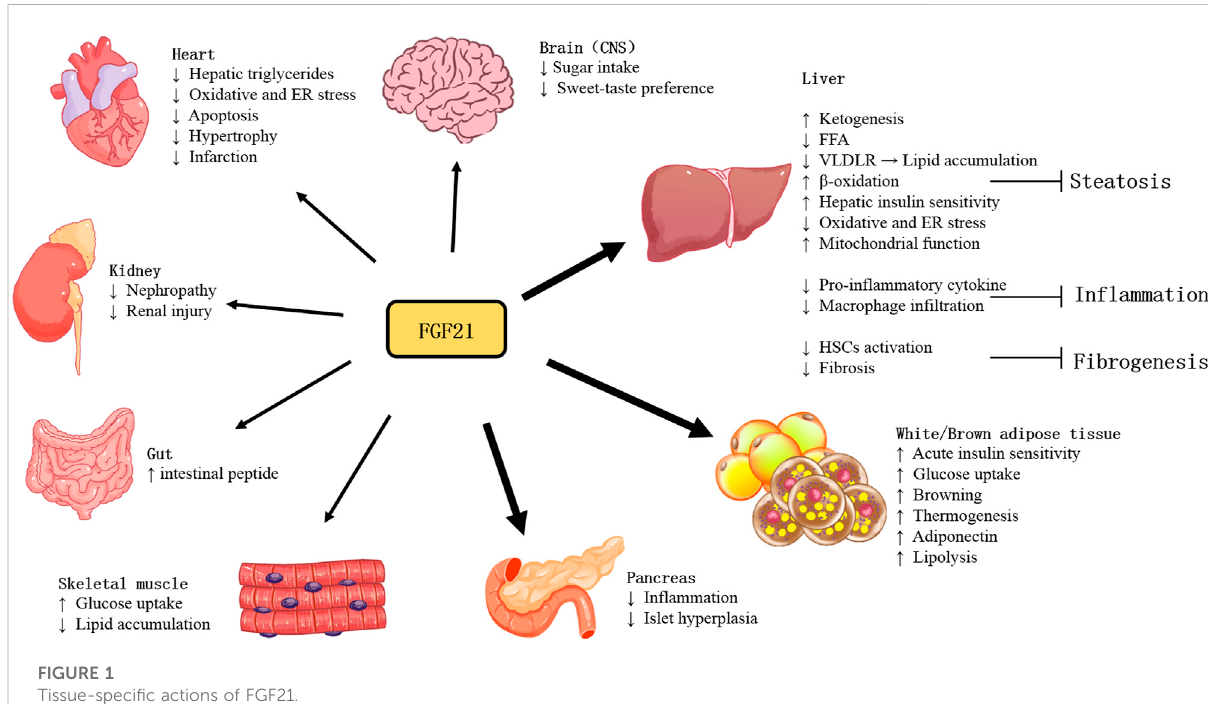
FIGURE 1 Tissue-speci fi c actions of